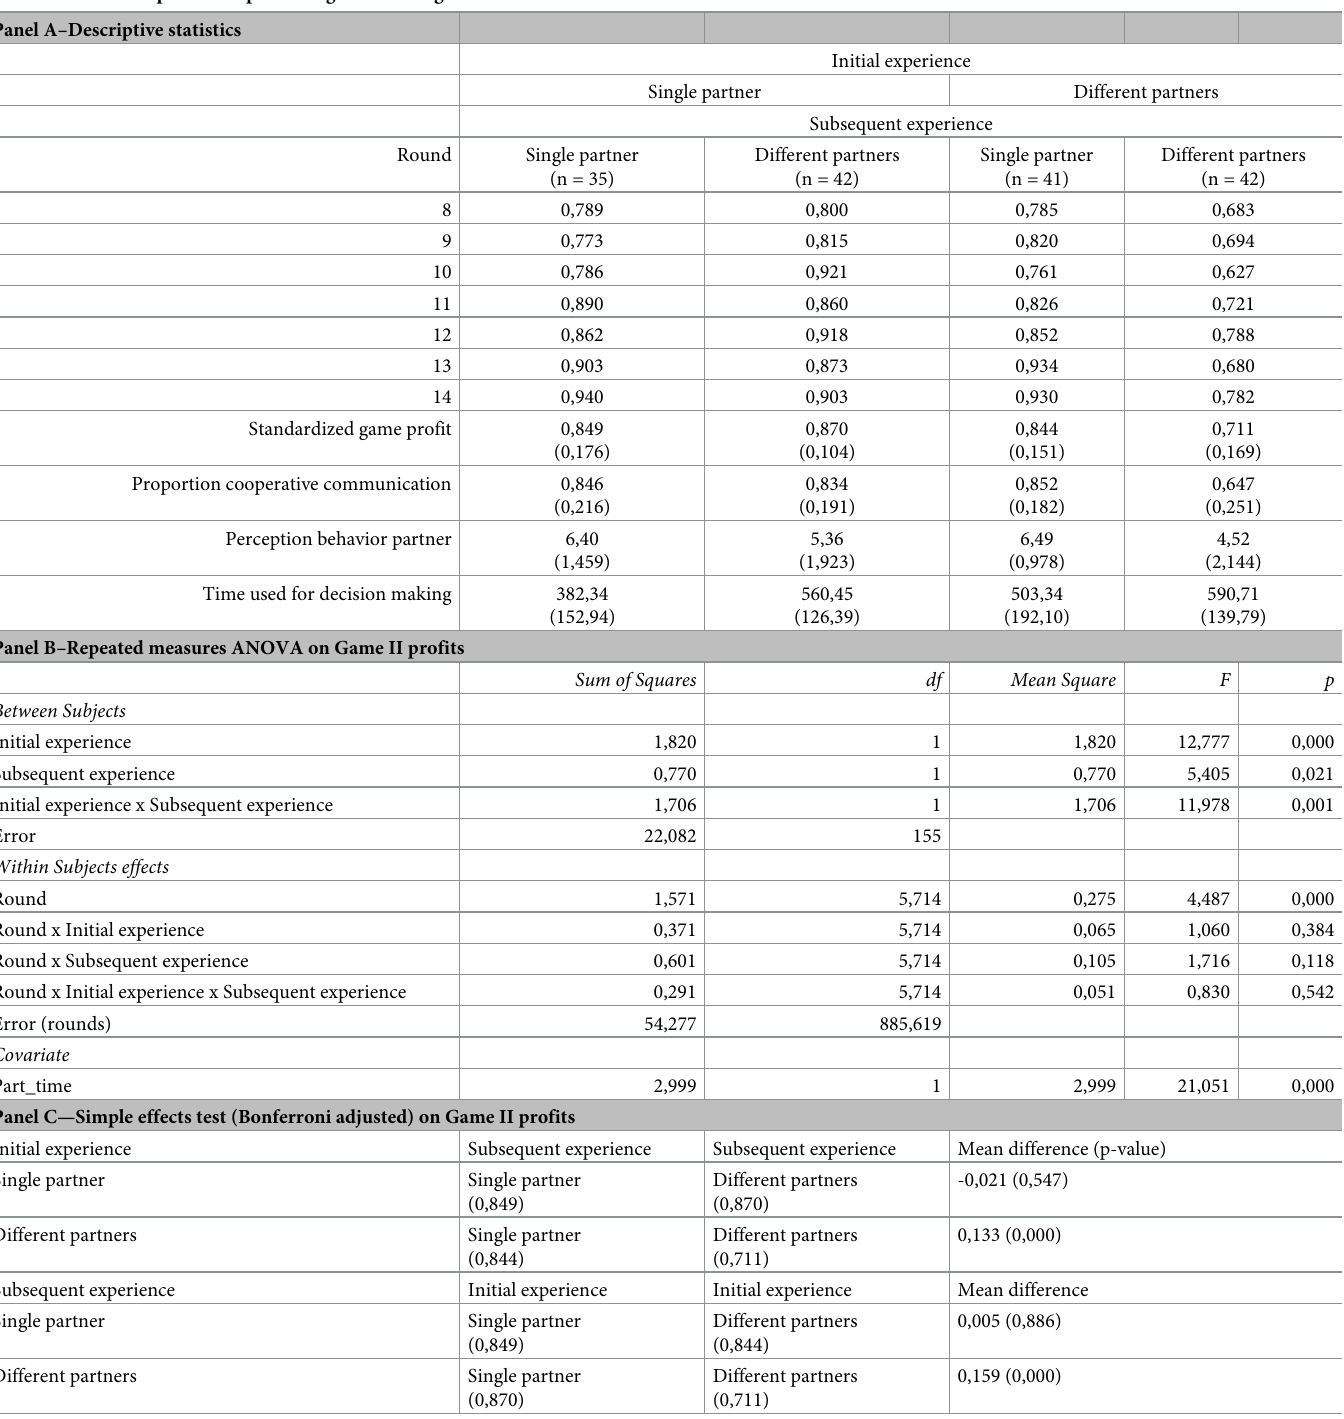
Table 5. Results on profits for partnering treatments game